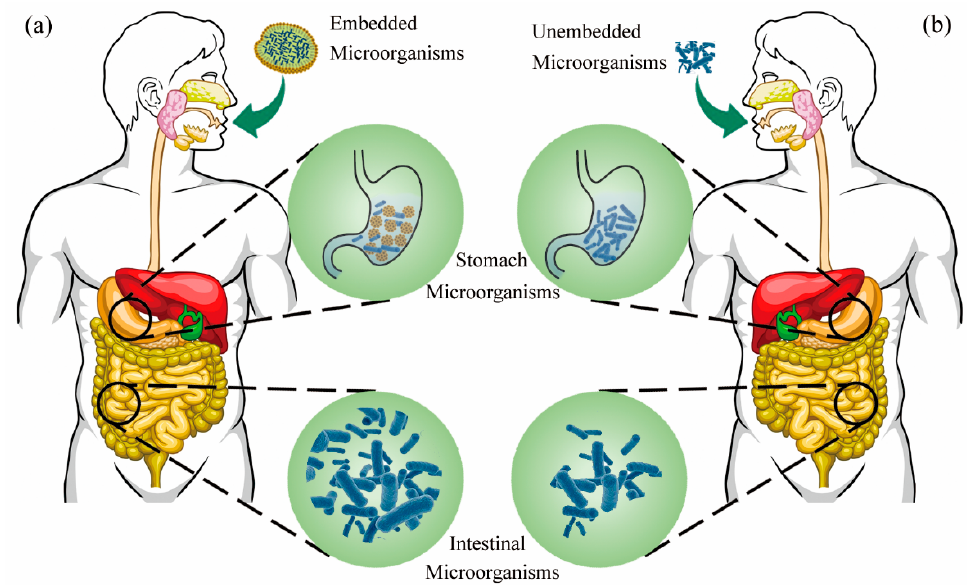
Figure 3. Protect effect of micro-encapsulated delivery system on probiotics. ( a ) Microorganisms enter the intestine under the protection of microcapsules; ( b ) microorganisms enter the intestine without the protection of microcapsules.